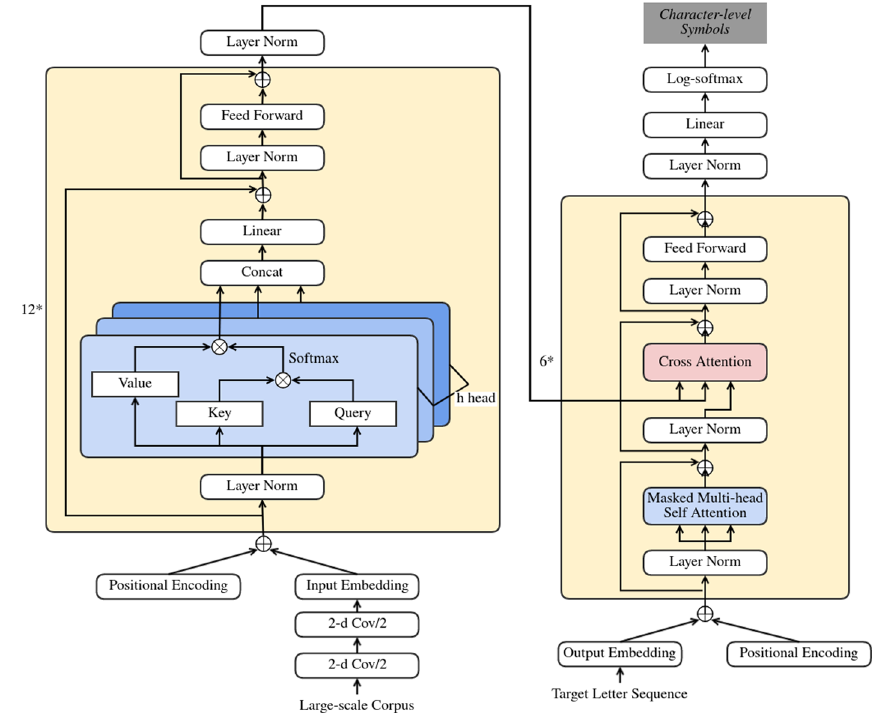
Fig. 2 The structure of the transformer-based acoustic